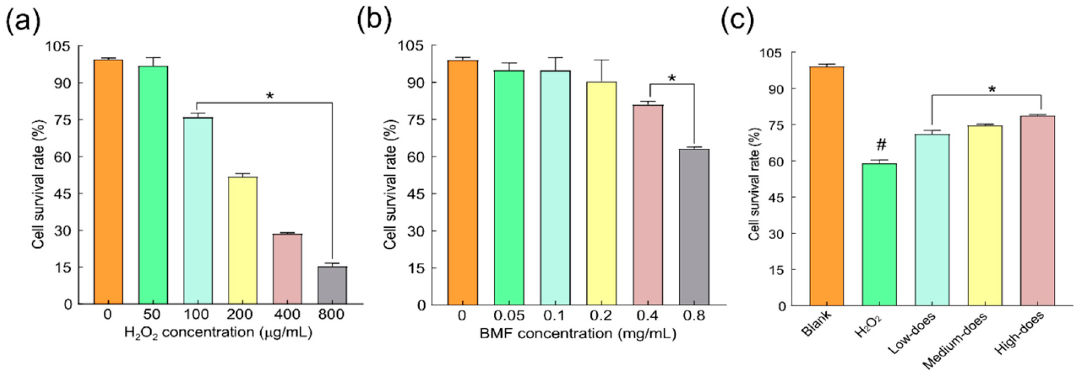
Figure 4. Effects of different concentrations of H 2 O 2 and flavonoids on the viability of rabbit lens epithelial cells. ( a ) Effects of BMF concentration on cell survival rate; ( b ) Effects of H 2 O 2 concentration on cell survival rate; ( c ) Effects of BMFs in different doses on the oxidative damage due to H 2 O 2 . # Symbolizes compared with blank group, p < 0.01; * symbolizes compared with H 2 O 2 injury group, p < 0.01 .